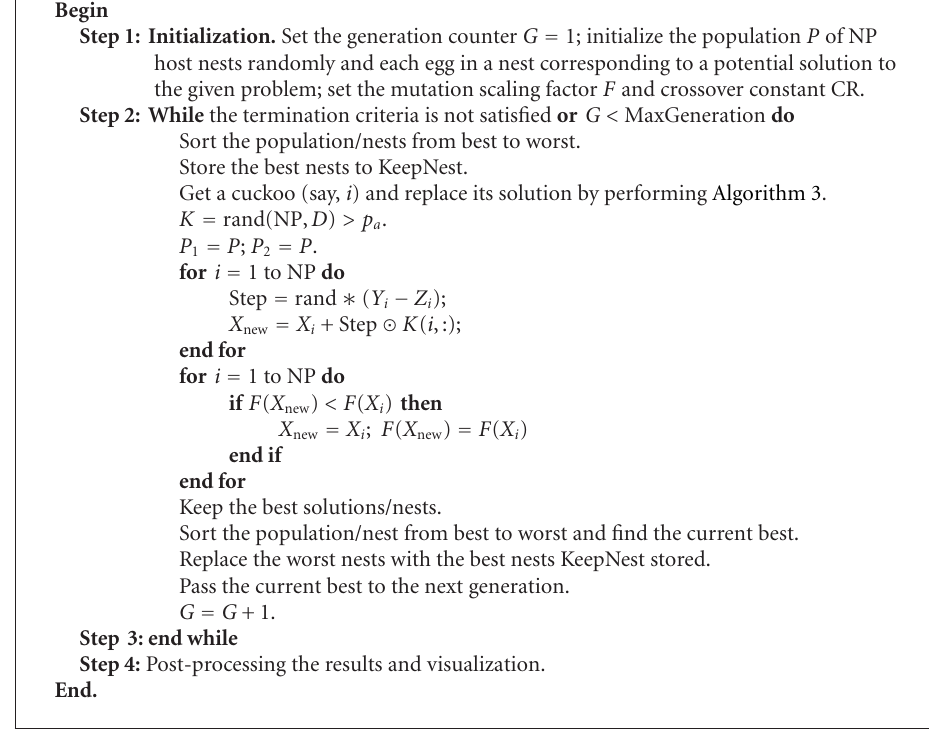
Algorithm 4: The main procedure of DE/CS.